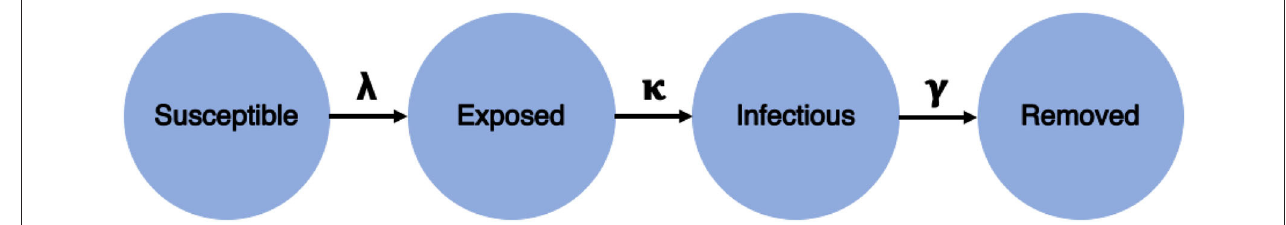
FIGURE 2 | SEIR (S denotes susceptible, E denotes exposed, I denotes infected, and R denotes removed) model